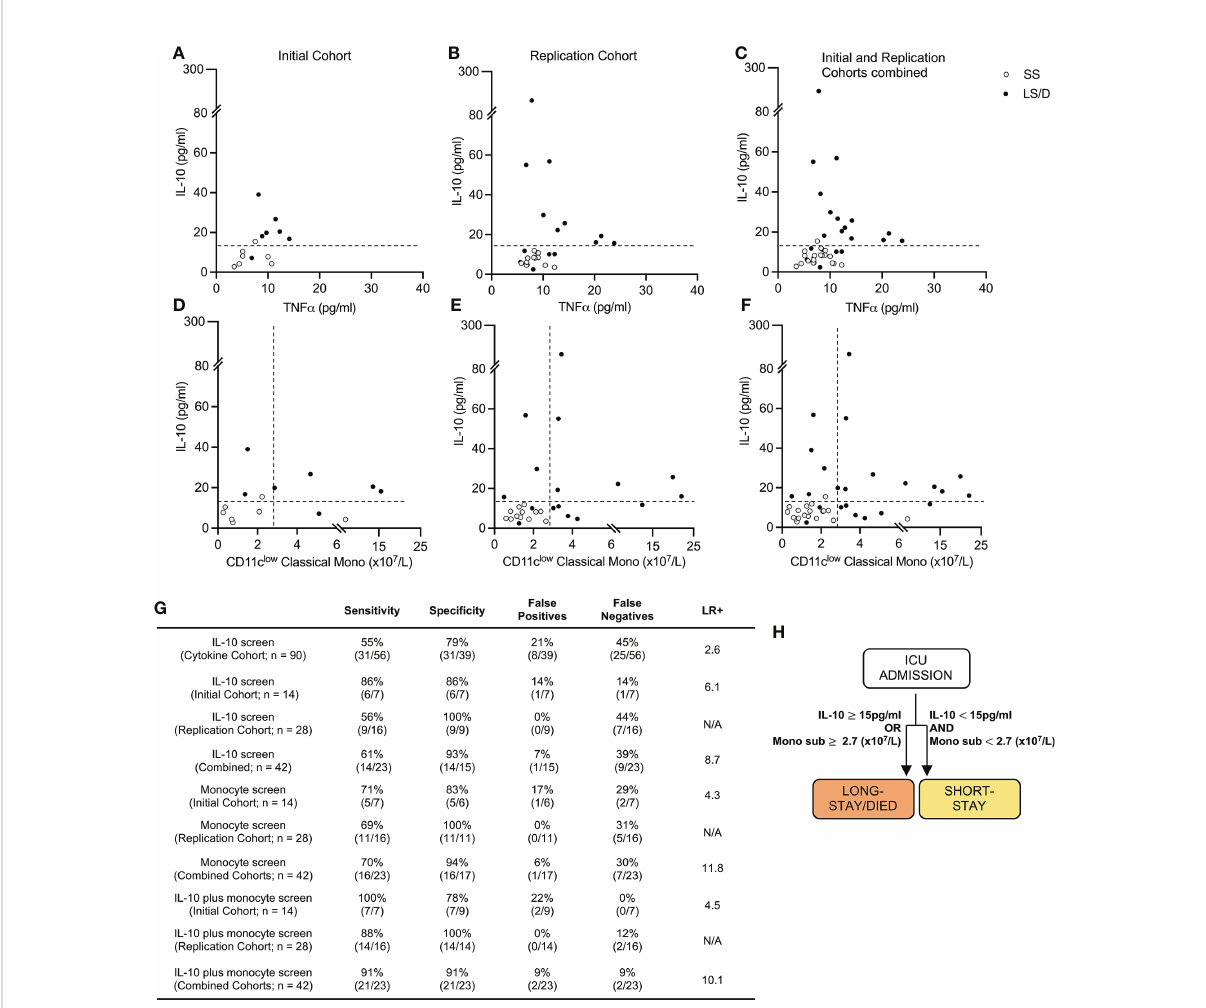
FIGURE 4 Prognostic cytokine and cellular biomarkers predict clinical outcome. Cytokine levels scatter plots of Initial (left), Replication (middle) and combined Cohorts (right) with dashed lines at cut-off value of 15pg/ml for serum IL-10 (A – C) . Cytokine and cellular levels scatter plots for Initial (left) Replication (middle) and combined cohorts (right) with dashed lines at cut-off values of 15pg/ml and 2.7 (x10 7 /L) of serum IL-10 and CD11c low classical monocytes respectively (D – F) . Sensitivity, Speci fi city and Positive Likelihood Ratio (LR+) calculations for each screen and cohort (G) . Prognostic patient screening chart based on serum IL-10 and CD11c low monocyte subset measurement (H) . “ Combined Cohorts ” represent merged Initial and Replication Cohorts. N/A, Not